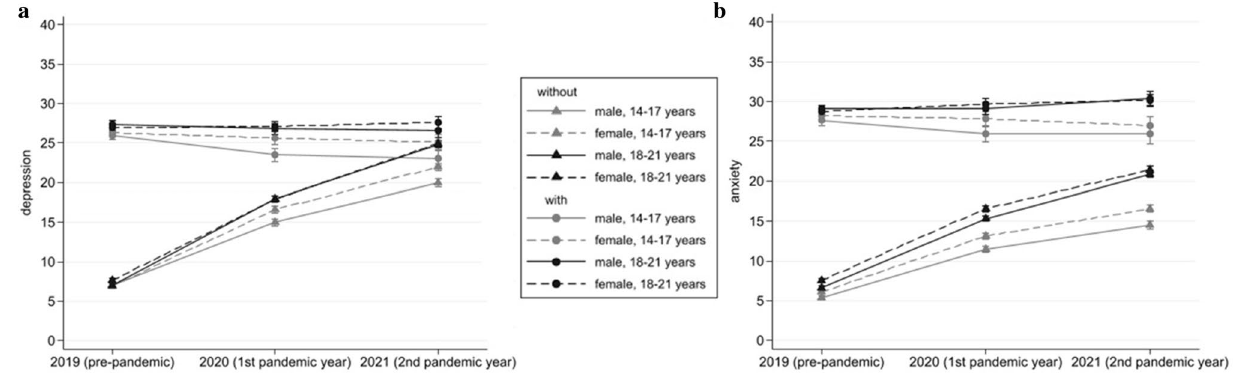
Figure 3. Estimated marginal means and 95% CIs on the depression ( a ) and anxiety ( b ) subscale across time, gender, age groups and pre-pandemic depression/anxiety status (with vs. without elevated symptoms) (N =